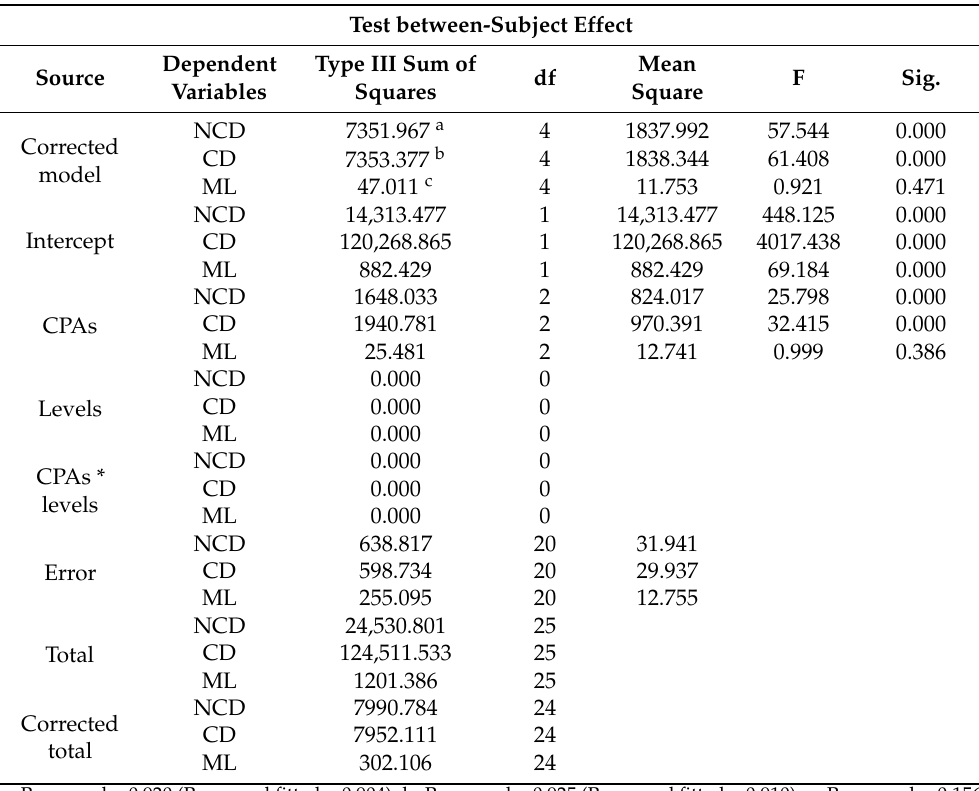
Table 3. Results of the test between-subjects effect (ANOVA) for the factorial 2 × 2 design on the fifth day (5) after thawing.